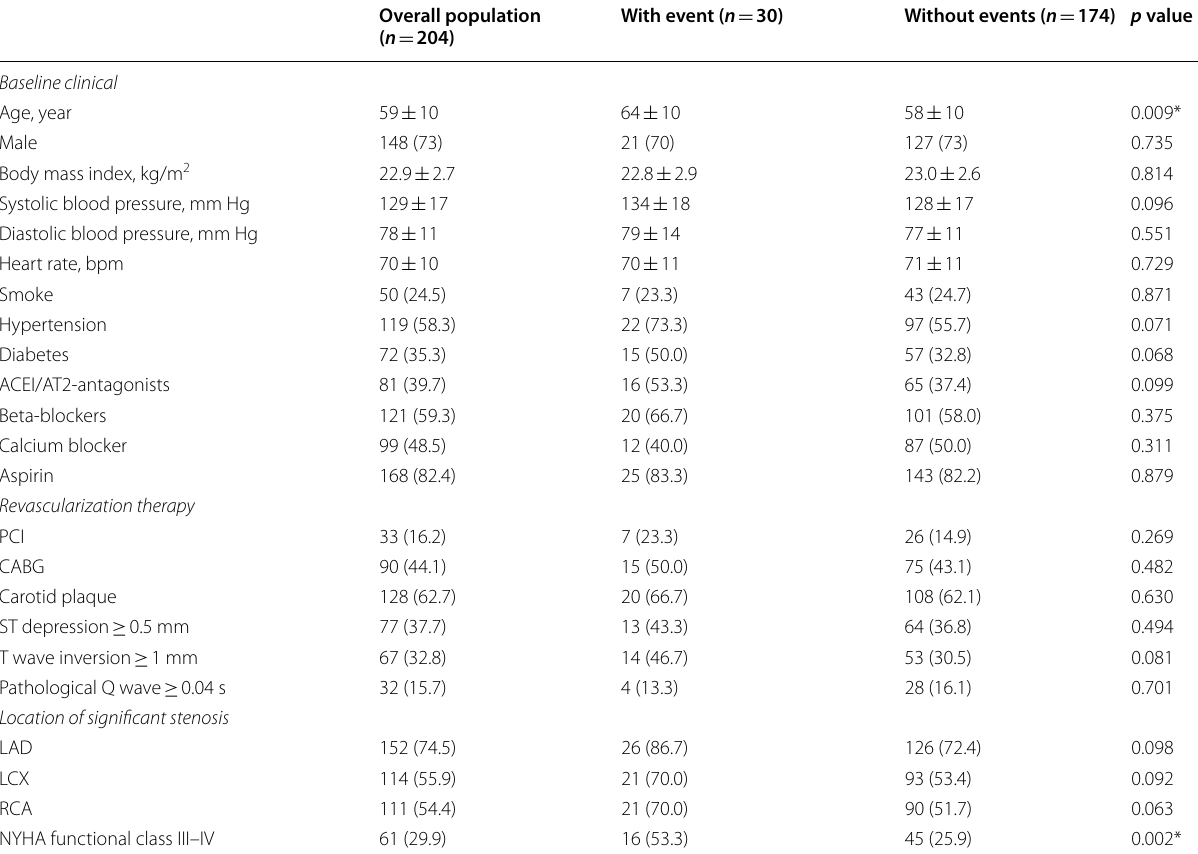
Table 1 Baseline characteristics stratified by follow-up outcome